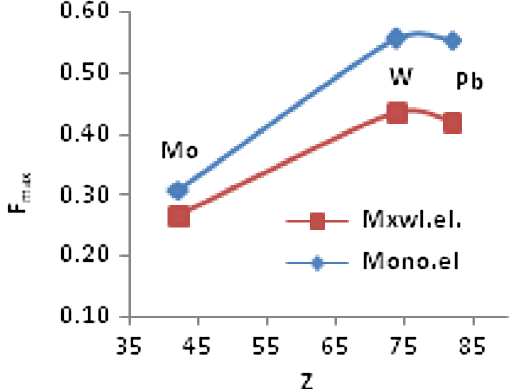
FIG. 7. A comparison of the x-ray fluxes maxima obtained by our experimental q -monoenergetic and q -Maxwellian electron distributions versus the atomic number, Z , for Mo ( Z ¼ 42 ), W ( Z ¼ 72 ), and Pb ( Z ¼ 84 ).